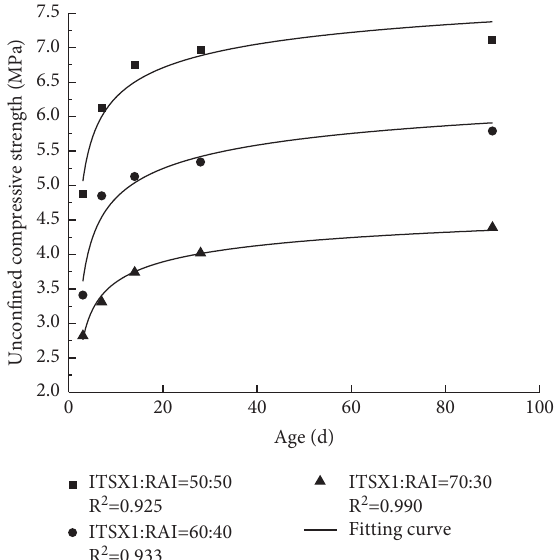
Figure 9: Compressive strength with different